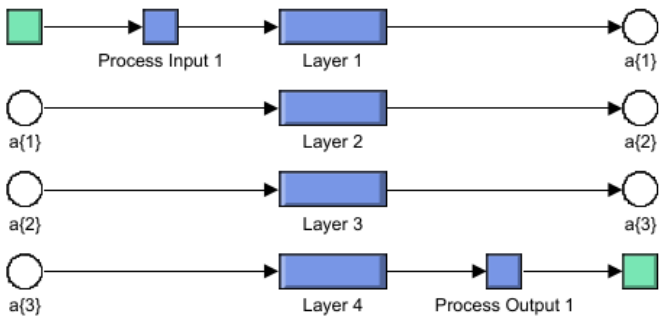
Figure 5. Twelve-sector DTC multilayer neural network architecture.